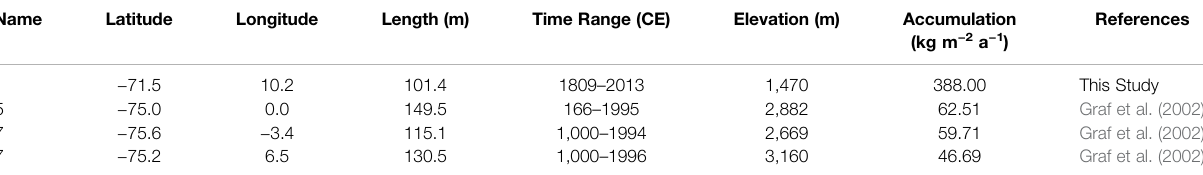
TABLE 1 | Ice cores from the DML region used in the present study.